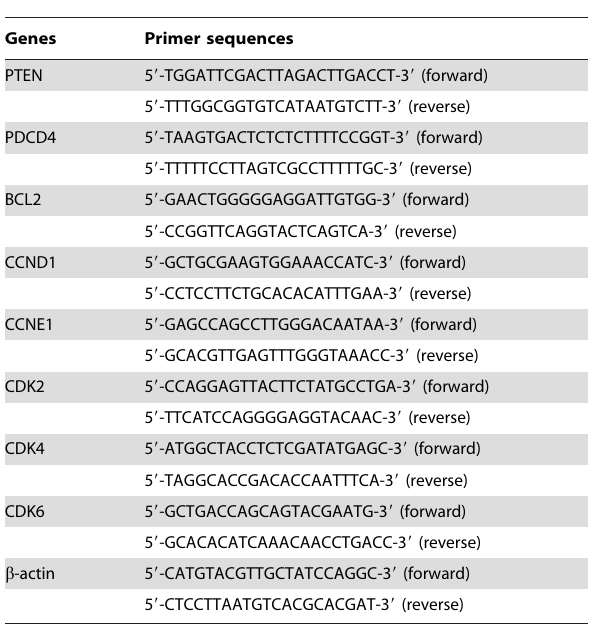
Table 3. Primers used for mRNA Expression